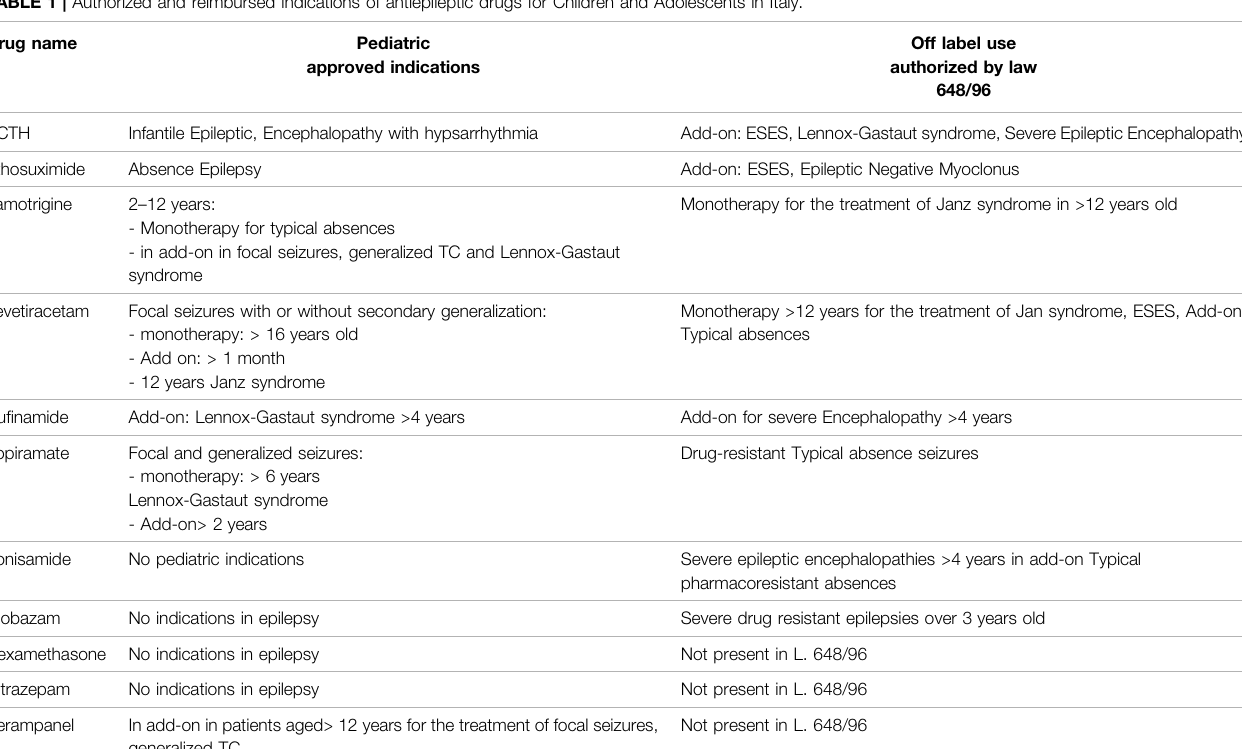
TABLE 1 | Authorized and reimbursed indications of antiepileptic drugs for Children and Adolescents in